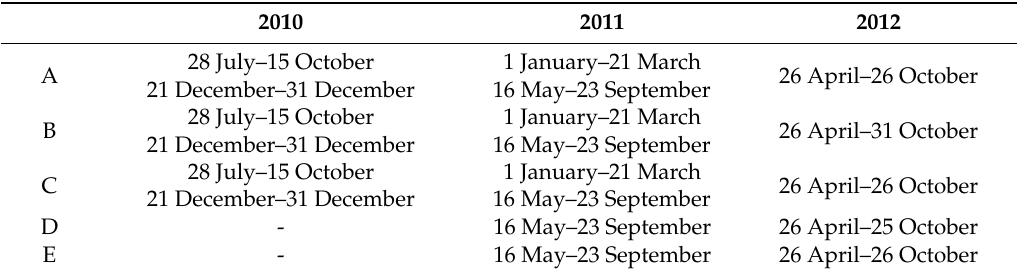
Table 1. Soil and water monitoring periods during 2010, 2011, and 2012 at the five monitoring